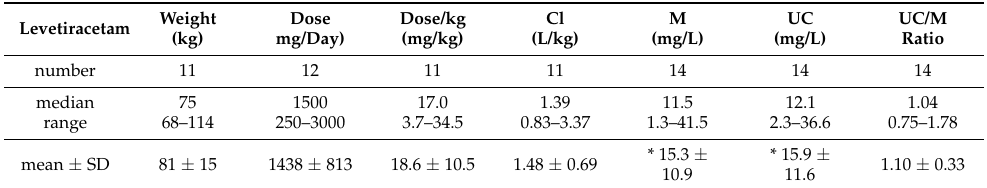
Table 2. Dosage, apparent oral clearance (Cl), maternal (M), and umbilical cord (UC) serum concen- trations of levetiracetam and its ratio at delivery.